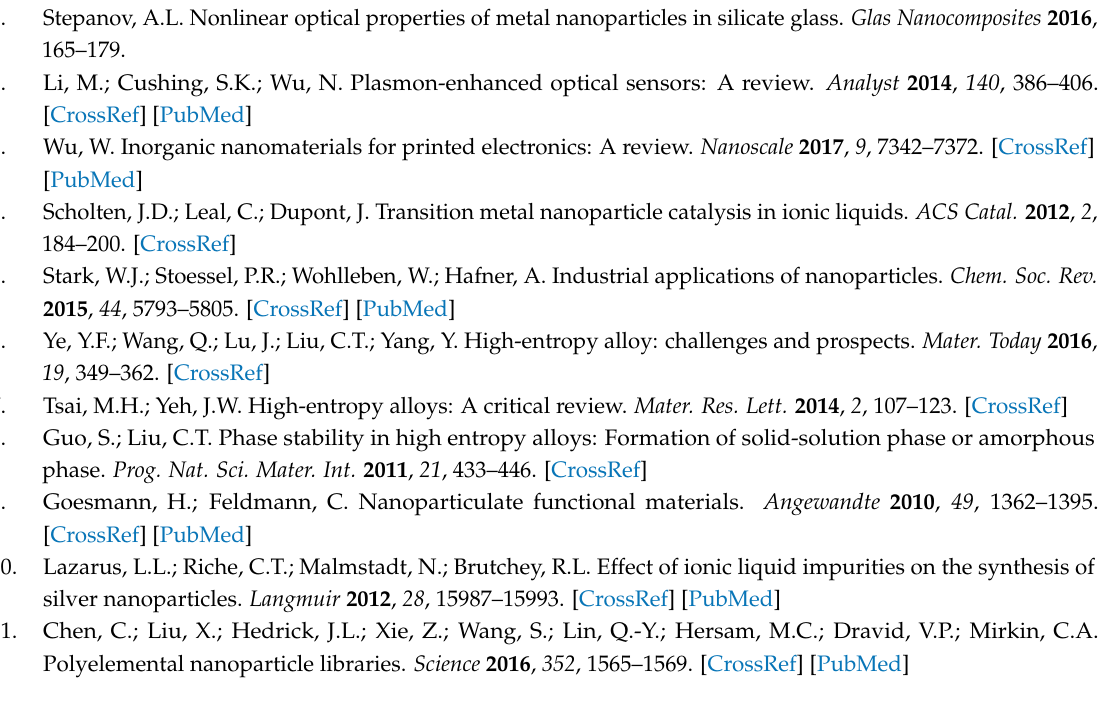
Figure S3: Histogram of the size distribution of HiPIMS sputtered multinary NPs (3.2 ± 0.5 nm) transferred on a carbon grid from the ionic